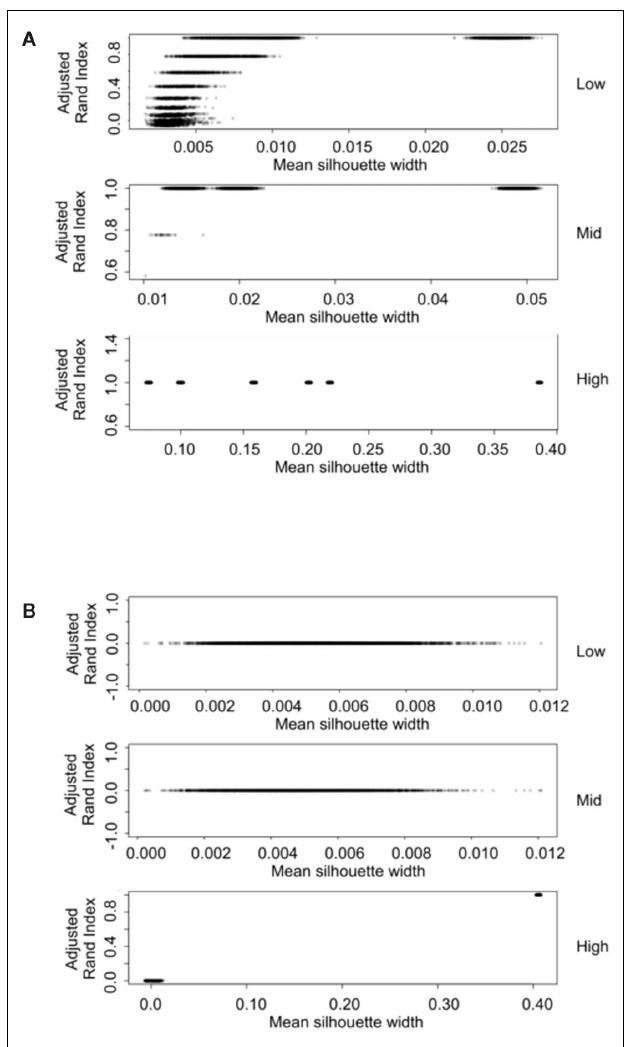
FIGURE 4 | Scatter plots of rand index versus mean silhouette width. A gray scale of dots is used to show the density of clustering, black dots represent highest density. Low (0.1 and 0.5% decisive data), mid (1% decisive data), and high (5 and 10% decisive data). (A) Results obtained using theWard linkage and Manhattan distance measures. (B) Results obtained using the centroid linkage and Euclidean distance